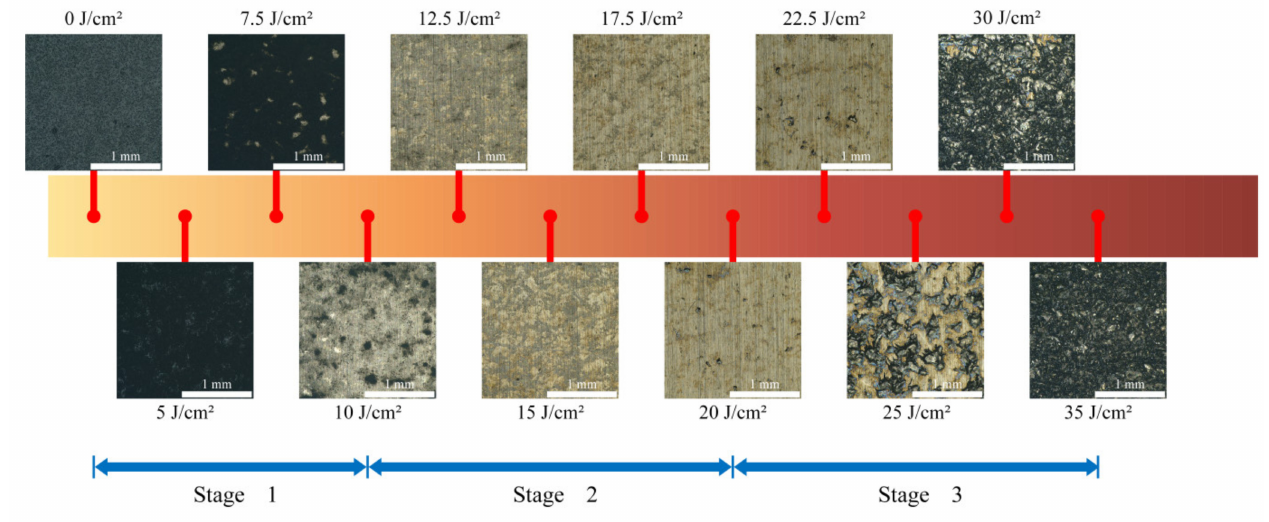
Figure 5. Effect of the energy density of a water jet-guided laser on the surface morphology of samples.